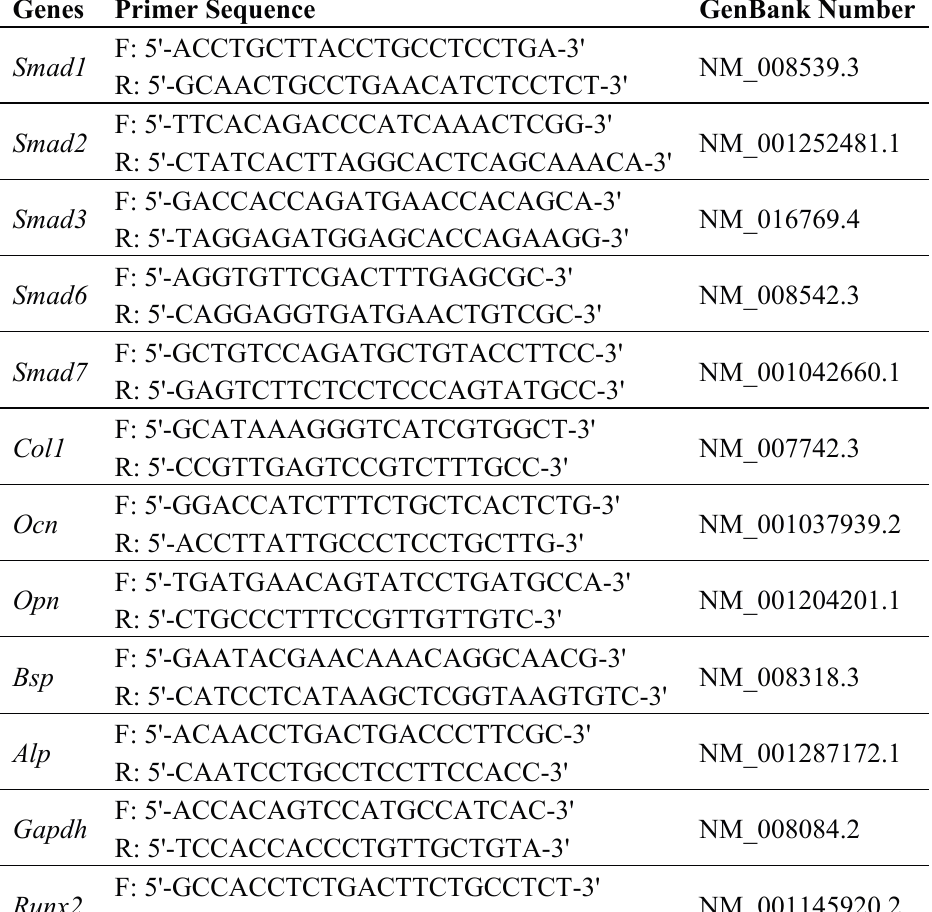
Table 1. Sequences of primers used for real-time PCR